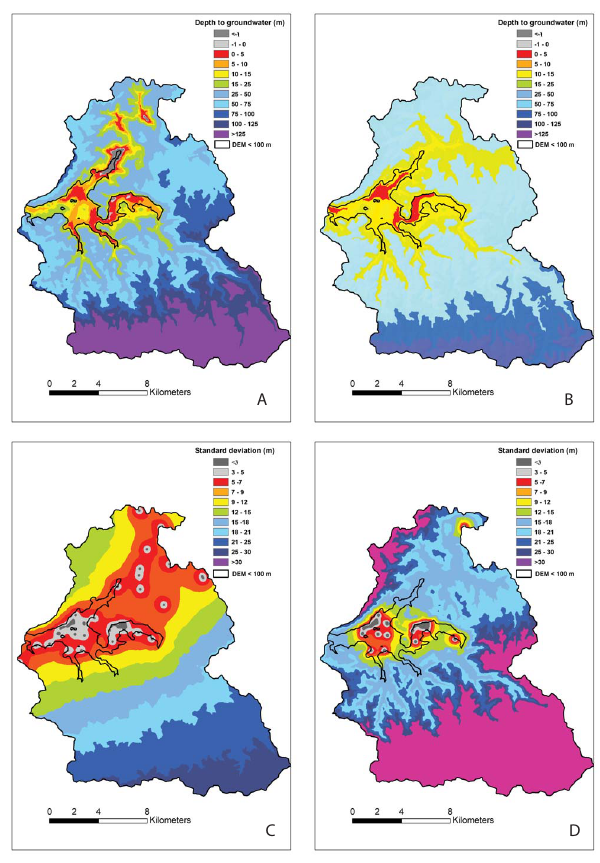
Figure 5. Depth to groundwater maps ( a – “potentiometric surface” (all bores), b – “water table” (shallow bores)) and Kriging standard deviation ( c – potentiometric surface, d – water table) for 1 Septem- ber 2009. Areas of shallow or intersecting (artesian) groundwa- ter are restricted to the Gellibrand River (centre) and Love Creek (north) valley